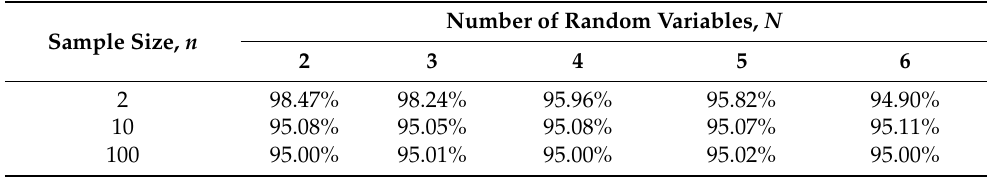
Table 2. Observed confidence level 100 ( 1 − ˆ α ) % as a function of the number of random variables N and sample size n